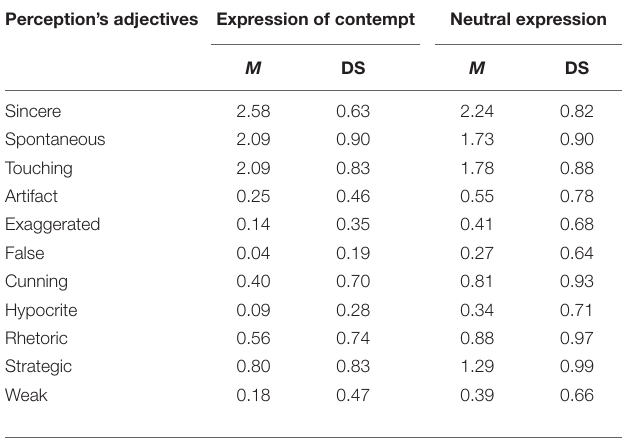
TABLE 1 | Average scores and standard deviation of perception’s adjectives in the experimental and control conditions (expression of contempt vs. neutral expression).